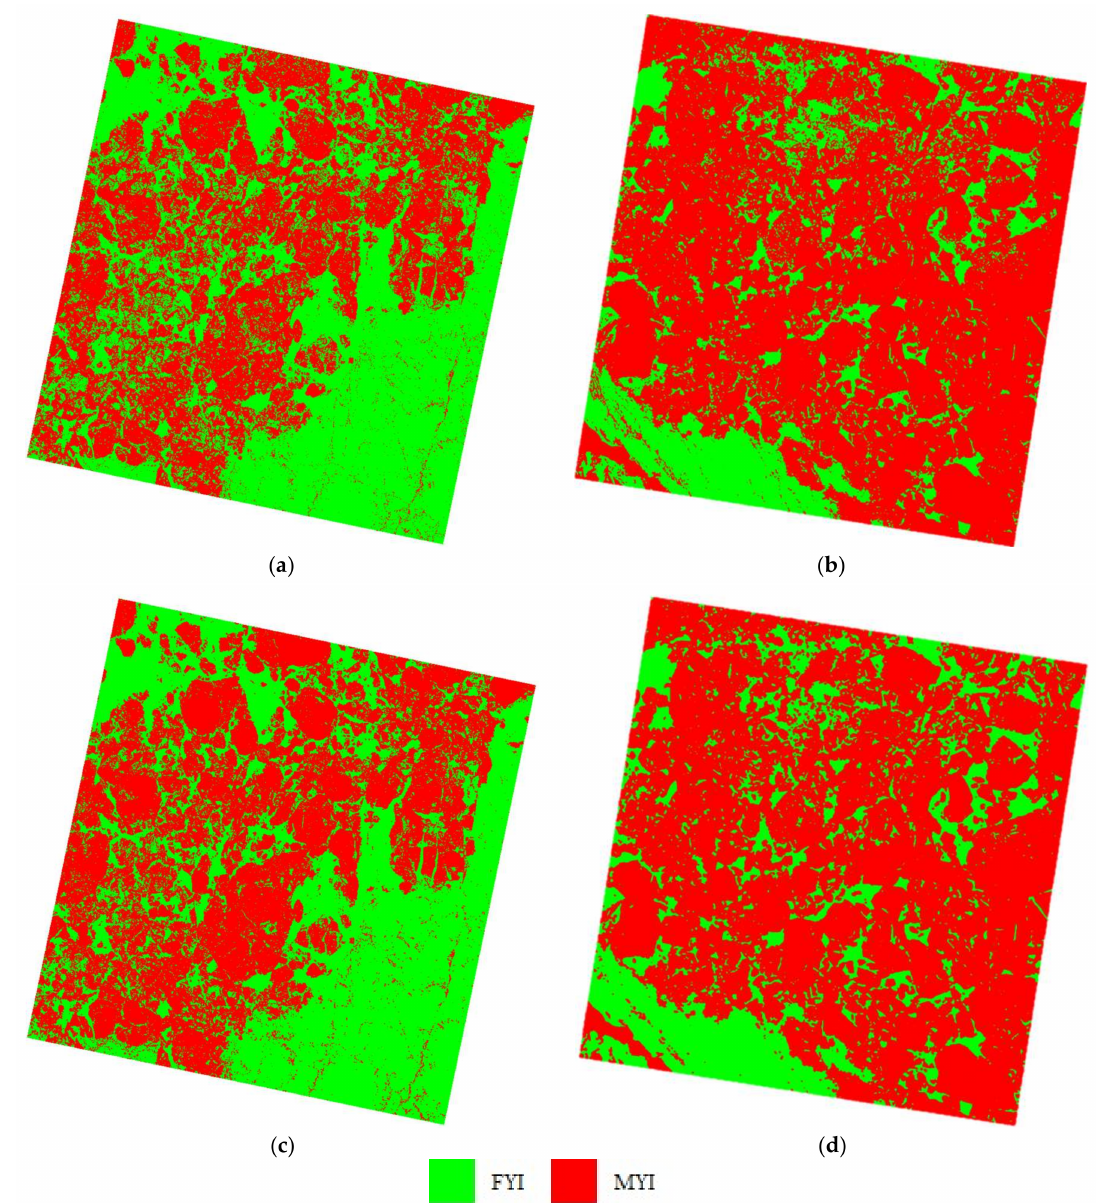
Figure 6. Classification results of the ( a ) Simulated RCM HR CP data over Victoria Strait; ( b ) Simulated RCM HR CP data over M’Clintock Channel; ( c ) FP SAR data over Victoria Strait; and ( d ) FP SAR data over M’Clintock Channel. Green color indicates FYI and red color indicates